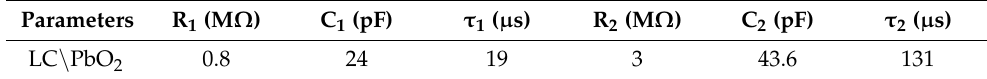
Table 1. Best-fitting parameters for sample LC/PbO 2 sheet according to the circuit shown in Figure 5a. Parameters